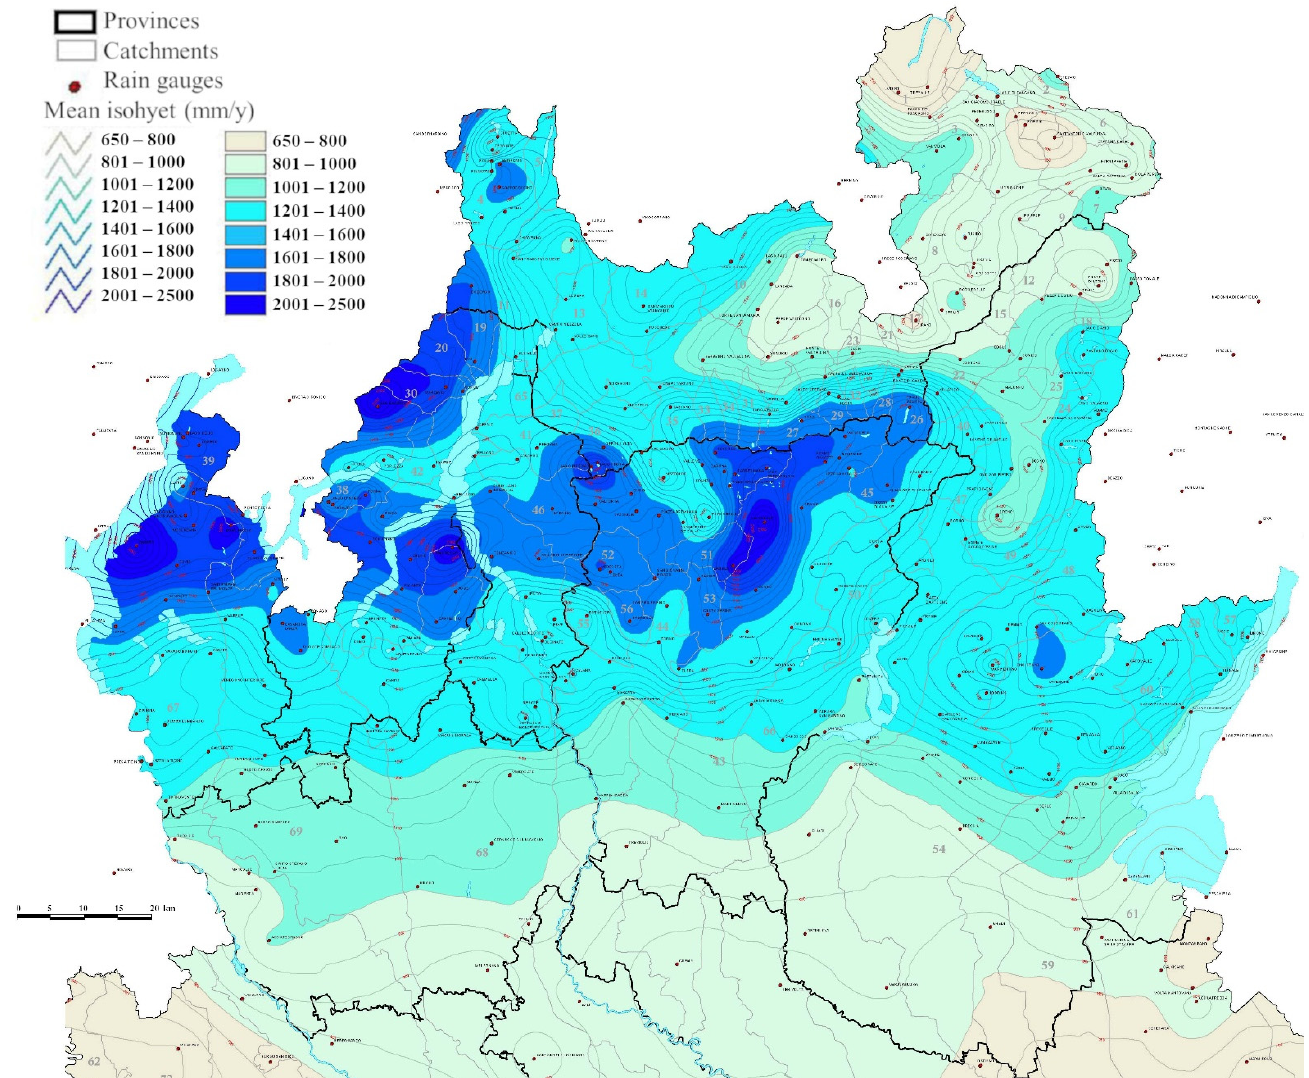
Figure 2. Map of the mean annual precipitation (MAP, in mm/y) in the 1891–1990 period in the alpine and pre-alpine districts of the Lombardy region [84].